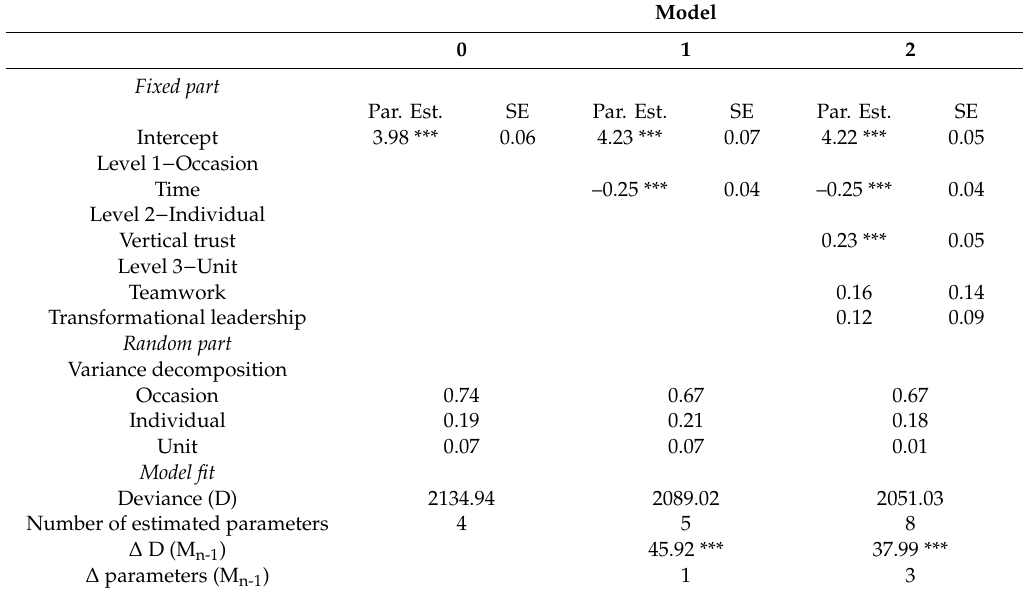
Table 4. Multilevel analysis predicting job satisfaction from time (Level 1), trust (Level 2), and teamwork and transformational leadership (Level 3). Model 0 1 2 Par.